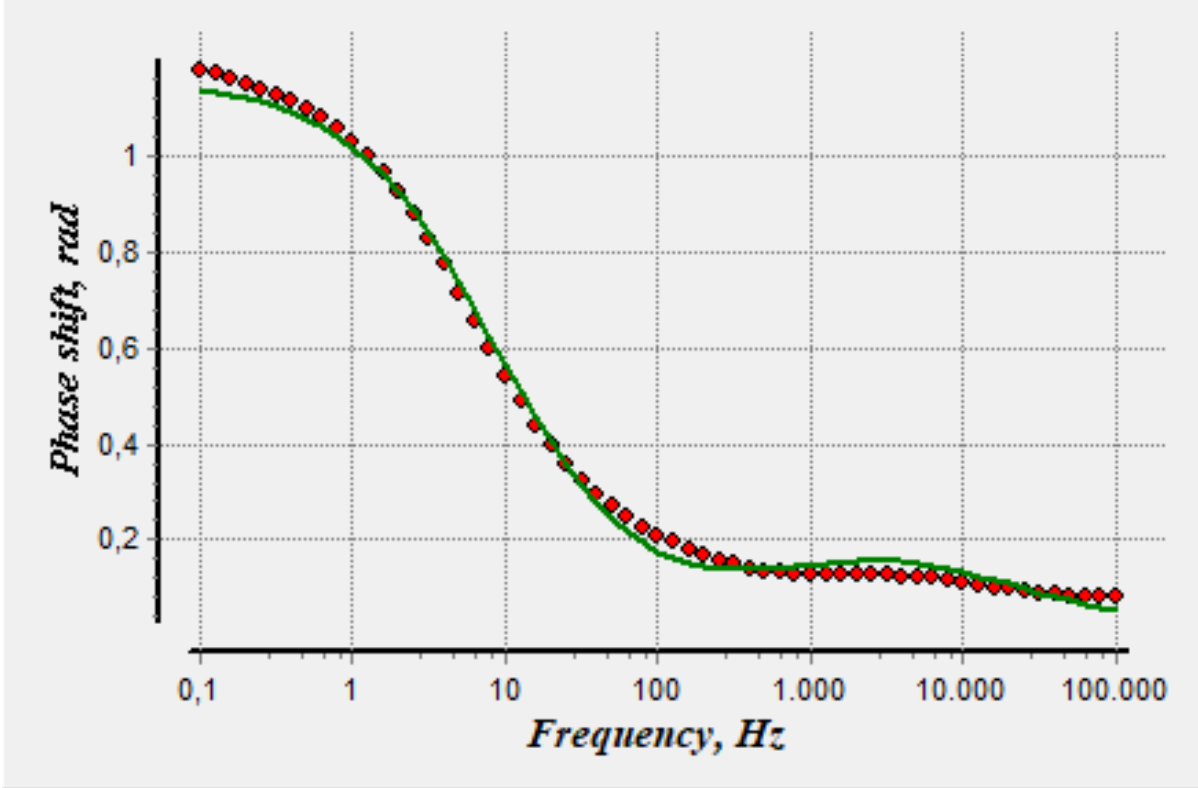
Figure 2S: Fitted impedance spectrum and the equivalent electric circuit of the electrochemical cell without biorecognition element on the working electrode